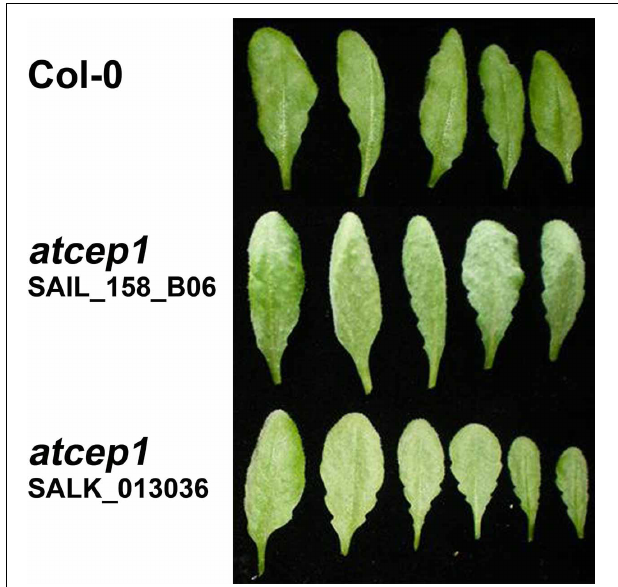
FIGURE 2 | Homozygous atcep1 knock out mutants with a T-DNA insertion in the 3. Exon exhibit enhanced susceptibility upon leaf inoculation with the biotrophic fungus Erysiphe cruciferarum . Leaves are shown 11 days post low density inoculation.